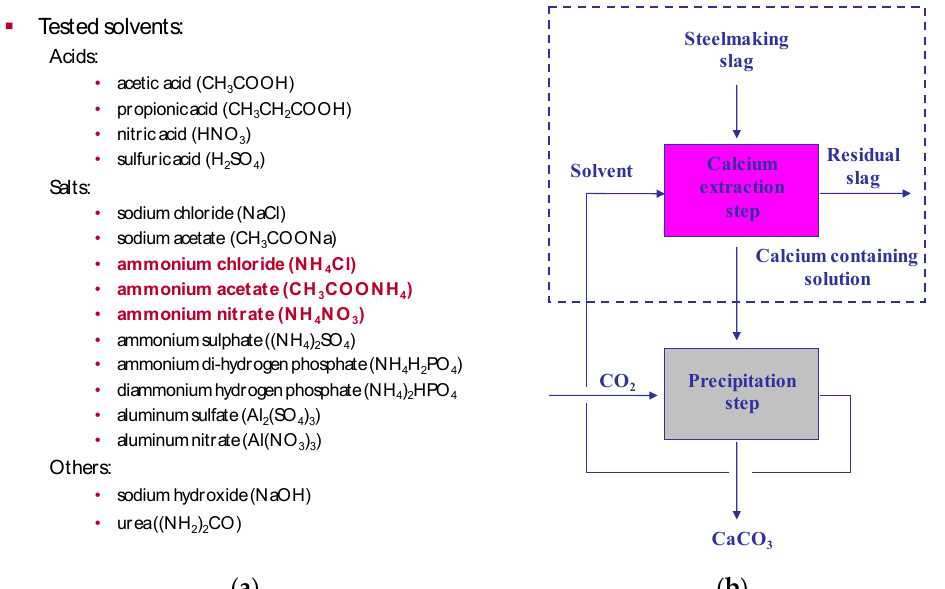
Figure 6. ( a ) Solvents tested as aqueous solutions for selective leaching of calcium from steel converter (basic oxygen furnace (BOF)) slags with three successful solvents highlighted. ( b ) Carbonation to produce PCC with the recycling of the leaching solvent.